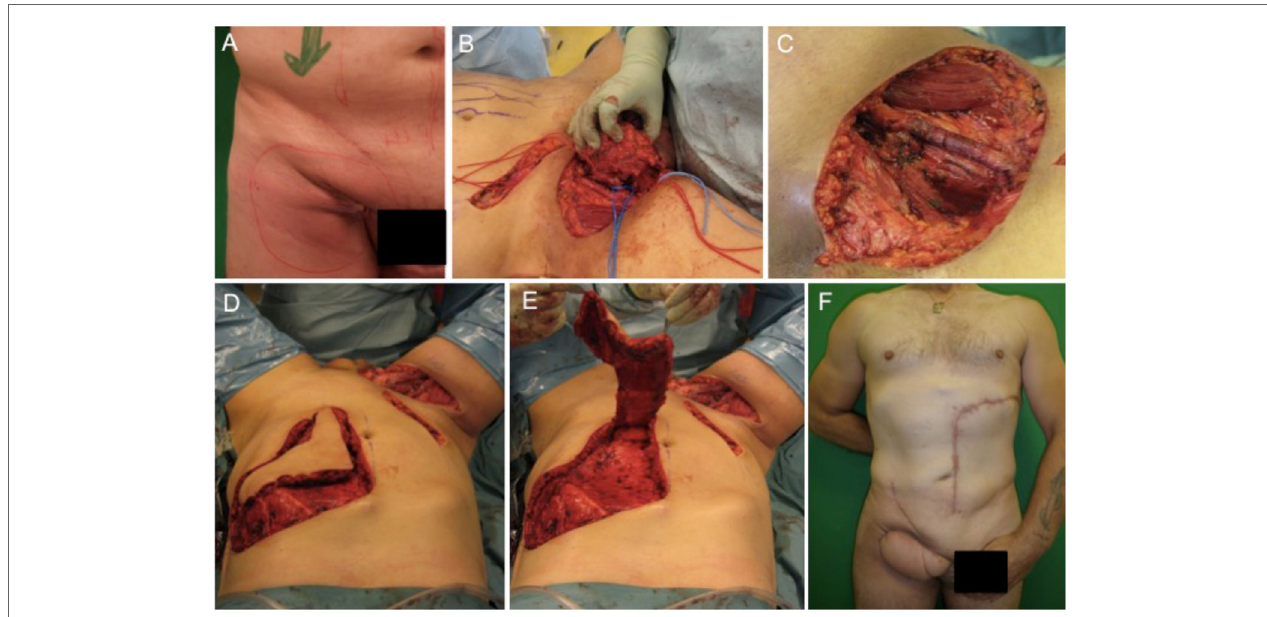
FiGURe 1 | Demonstration of tumor at the right inguinal region expanding on the proximal thigh (A), complete metastatic resection was performed with preservation of inguinal vessels and femoral nerve (B,C) . As a next step, an extended VRAM flap from the contralateral side was prepared and transferred for defect closure (D,e) . Long-term results revealed complete removal and stable coverage with minimal donor morbidity (F)